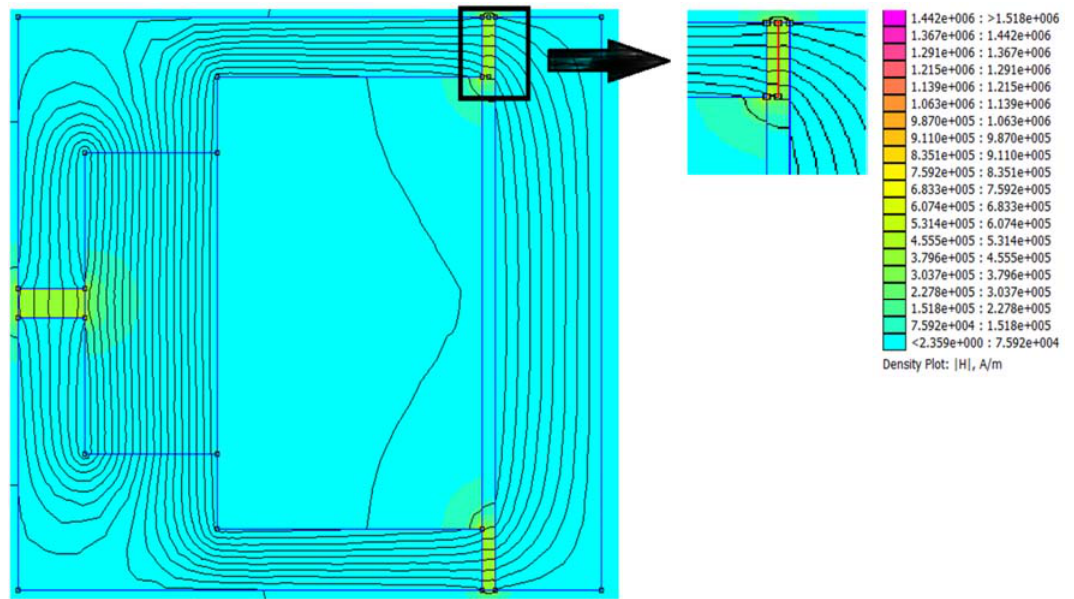
Fig. 8. The NC MR valve magnetic field strength